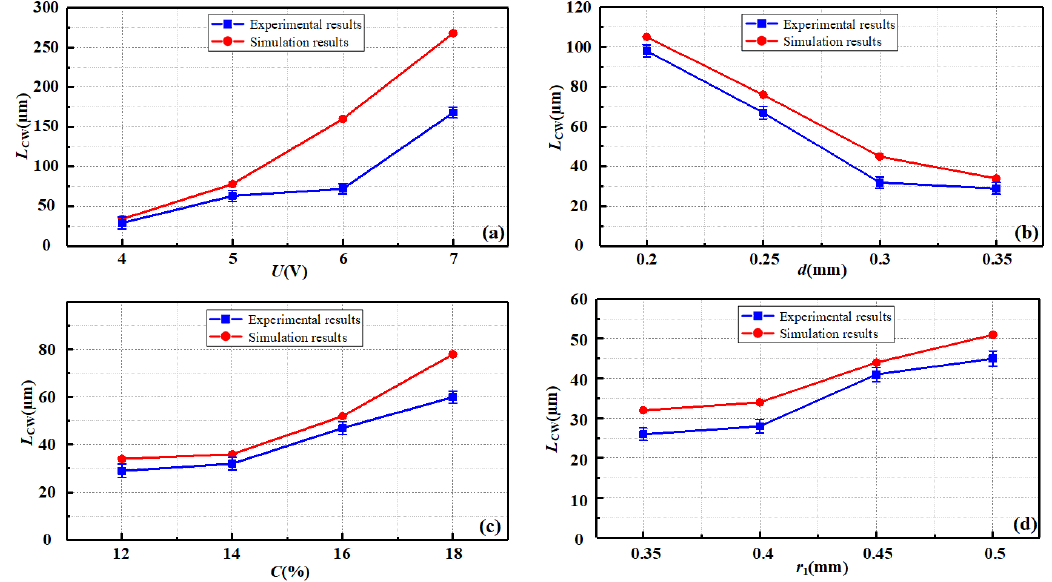
Figure 22. L CW comparison curve: ( a ) Effect of machining voltage; ( b ) Effect of initial machining gap; ( c ) Effect of electrolyte concentration; ( d ) Effect of electrode radius.